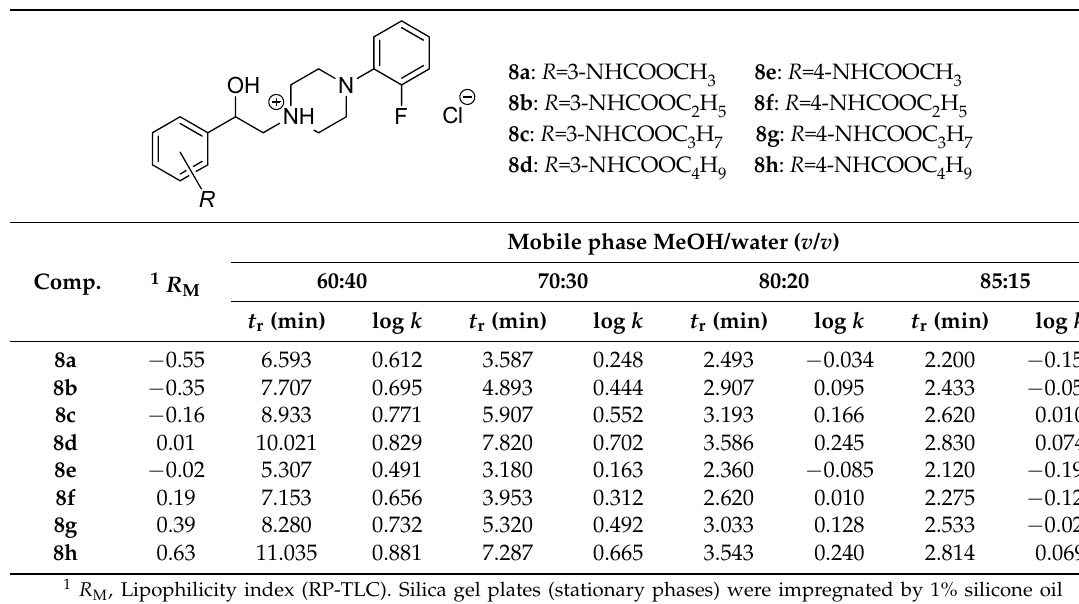
Table 1. Chemical structure of the compounds 8a – h , their lipophilicity indices R M (RP-TLC) and log k (RP-HPLC) as well as retention times t r (RP-HPLC) estimated in the mobile phases consisted of a various volume ratio ( v / v ) of a methanol (MeOH) organic modifier and water.